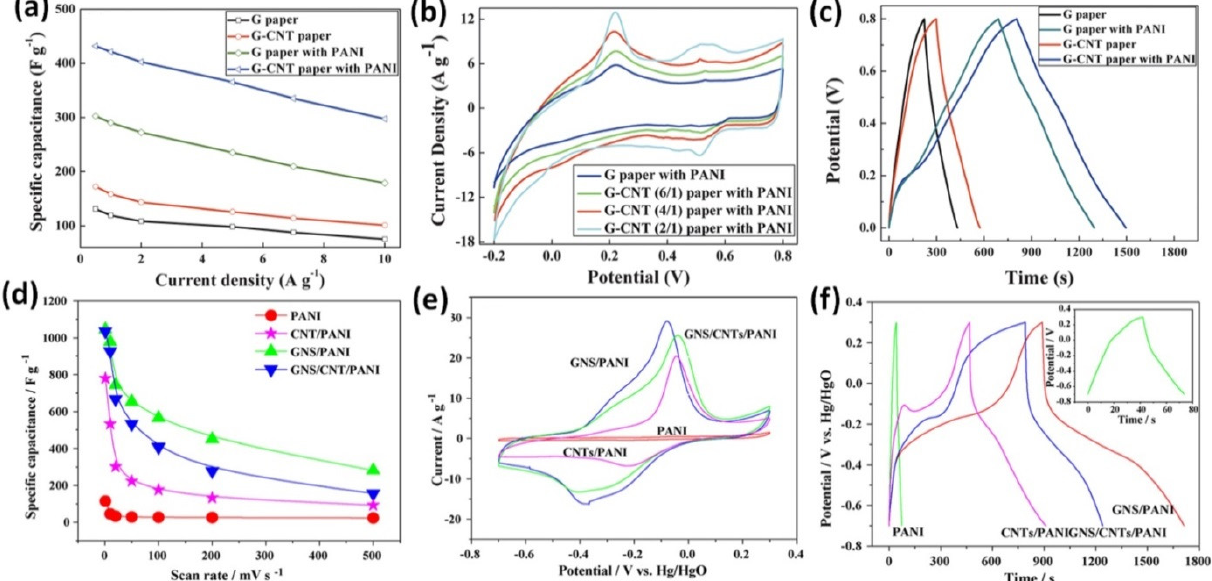
Figure 13. CV curves of G/PANI hybrid paper and G-CNT/PANI ternary hybrid papers at a scan rate of 10 mV/s ( a ); GCD curves of G paper and G–CNT composite paper with and without immobilized PANI particles at a current density of 0.5 A/g ( b ); specific capacitances of G paper and G-CNT composite paper with and without immobilized PANI particles as a function of current density ( c ) (Reprinted from [120] with permission of RSC Publishing). CV curves of pristine PANI, CNT/PANI, GNS/PANI, and GNS/CNT/PANI composite at 10 mV/s ( d ), GCD tests of pristine PANI and as-prepared composites at 2 mA/cm 2 ( e ); specific capacitance of PANI and PANI-based composites at different scan rates ( f ) (Reprinted from [121], Copyright 2009, with permission from Elsevier).